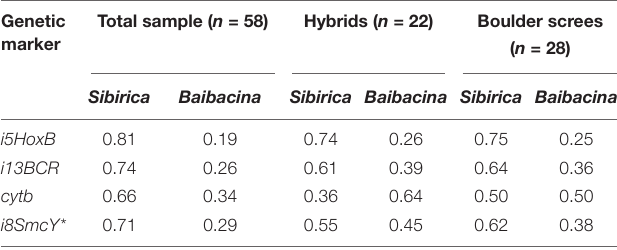
TABLE 2 | Frequencies of species-specific haplotypes of molecular genetic markers in the mixed marmot population in the Ulagchin-Gol valley. Genetic